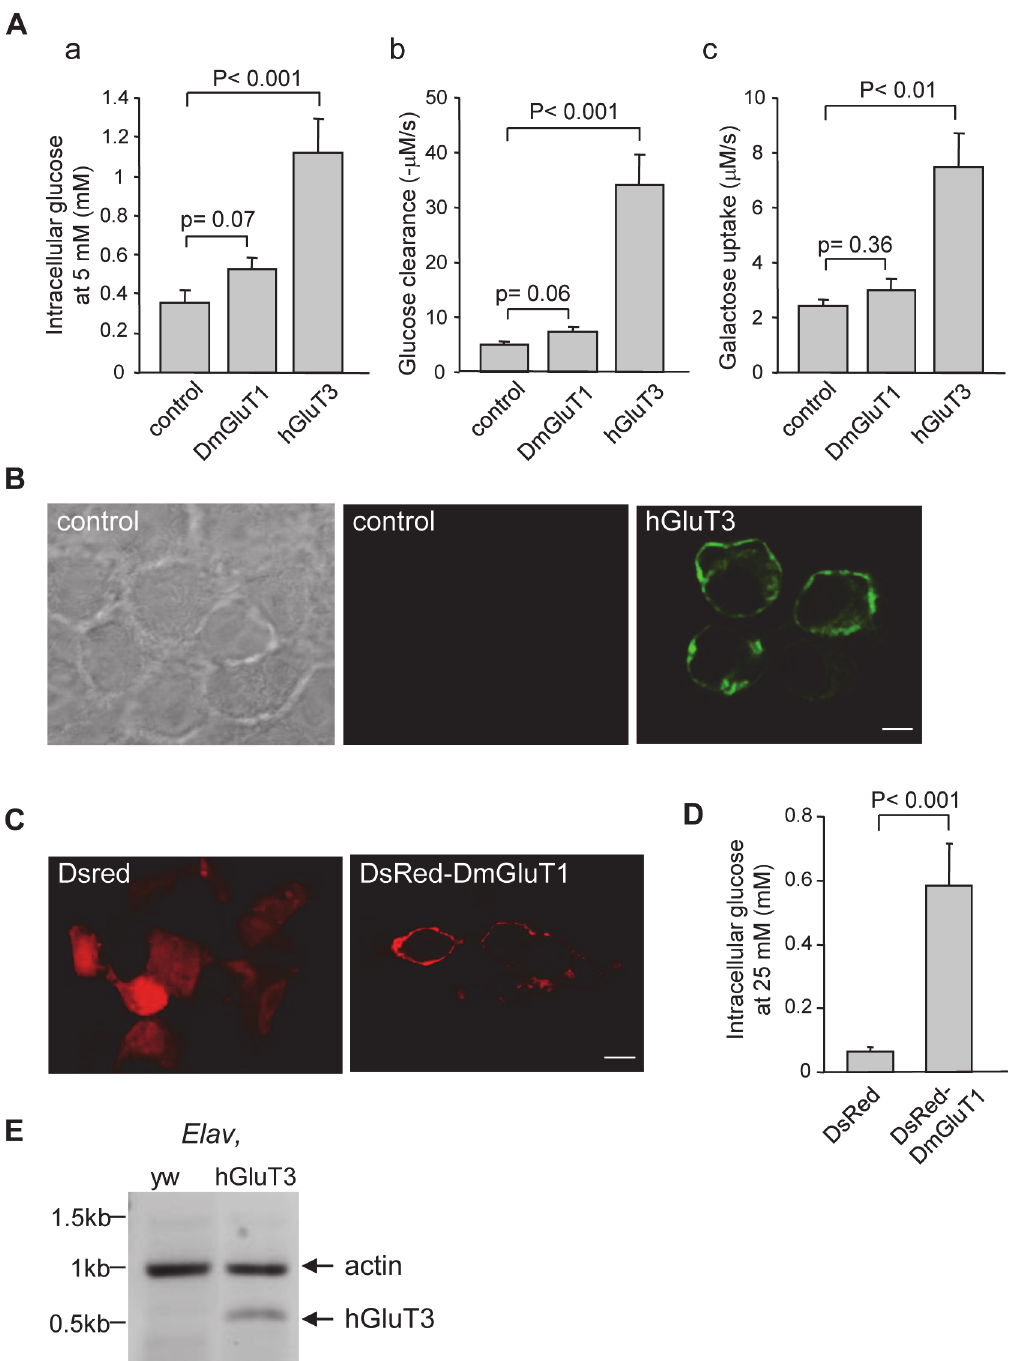
Fig 1. Expression and functional characterization of DmGluT1 and hGluT3. ( A ): Measurements of uptake parameters. HEK 293 cells were transfected with the glucose sensor and either an empty (control), DmGluT1 , or hGluT3 plasmids. Only hGluT3 expression resulted in very significant increases in intracellular glucose concentration at 5mM extracellular glucose (a), glucose clearance (b) and galactose uptake (c). ( B ): hGluT3 immunodetection: HEK-293 cells transfected with the empty plasmid were not labelled, with the hGluT3 antibody (middle panel) whereas hGluT3 -transfected cells revealed plasma membrane localization (right panel). The left panel shows hGluT3 -transfected cells in bright field. Scale bar: 5 μ m. ( C ): Detection of the DsRed-DmGluT1 (right panel) showing its localization at the plasma membrane; The left panel shows DsRed -transfected cells as control. Scale bar: 5 μ m. ( D ): Exposure of DsRed - DmGlut1 cells to 25 mM extracellular glucose resulted in significantly higher intracellular glucose relative to control cells. ( E ): Detection of hGluT3 and actin mRNA in flies expressing no transgene or hGluT3 under the control of the Elav- Gal4 driver. RT-PCR analysis was performed from Drosophila heads at 4 days of adult